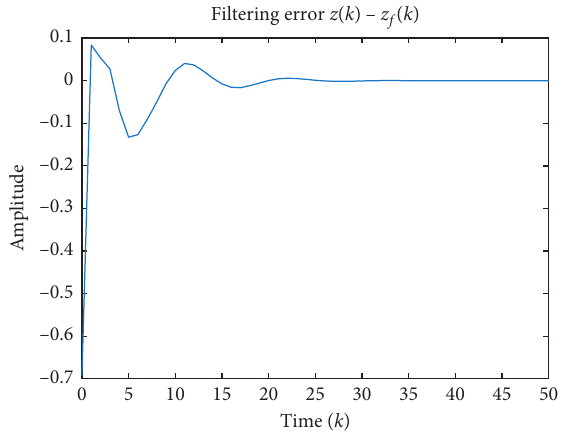
( k ) in Example 3. f